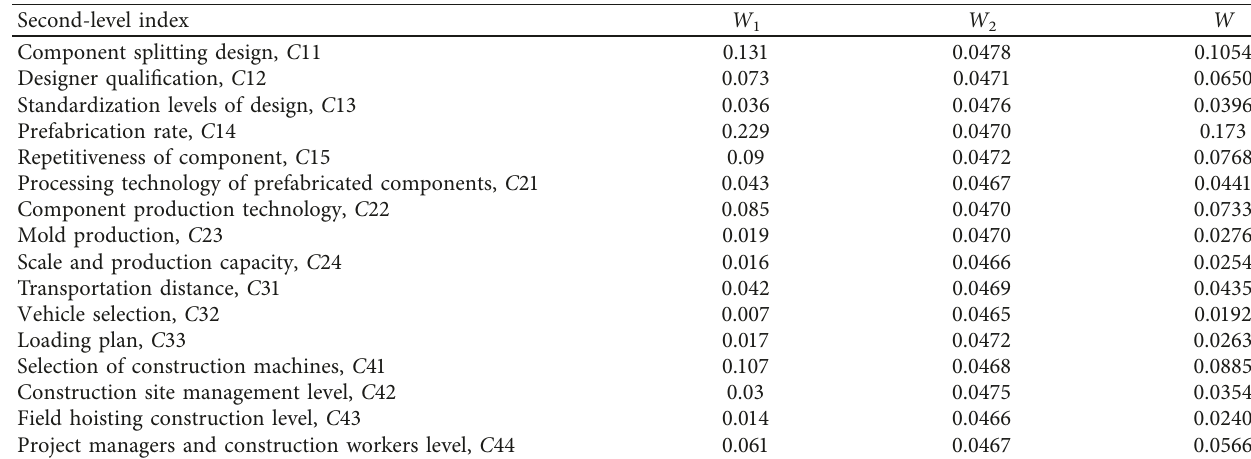
Table 12: Comprehensive weight of the second-level index.